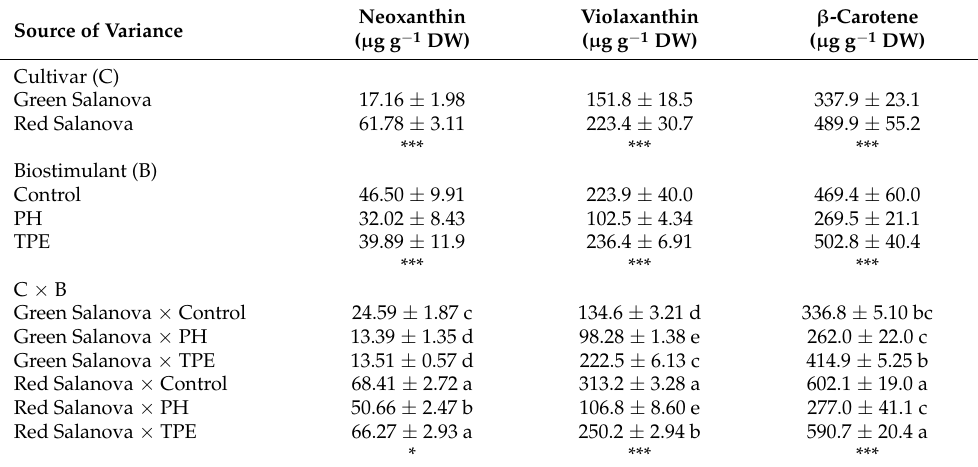
Table 7. Carotenoid content of red and green salanova lettuce and the influence of biostimulant treatments.